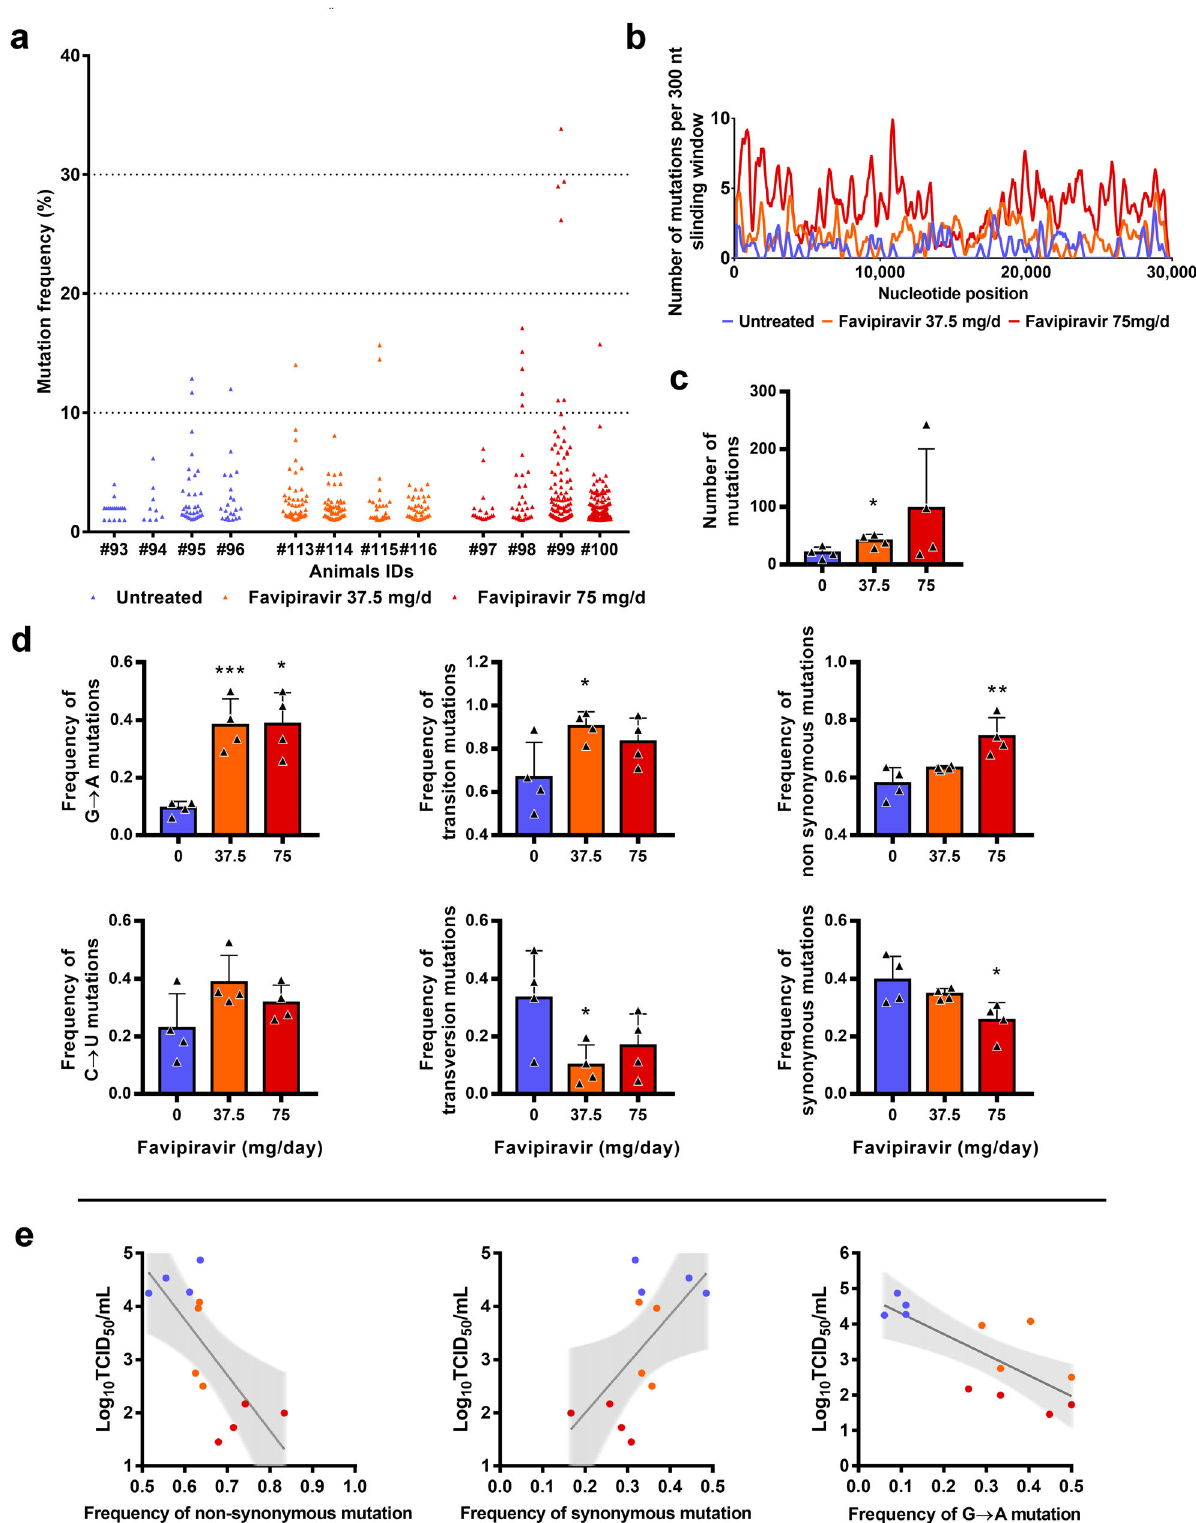
since it is recognized as a purine nucleotide by the viral RNA- dependent RNA polymerase. It is metabolized intracellularly to its active form and incorporated into nascent viral RNA